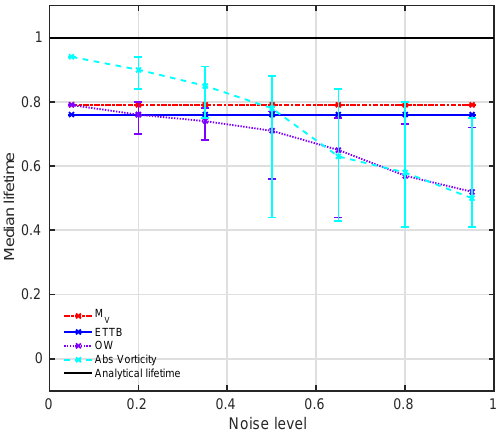
Figure 8. Measured median lifetime obtained by different methods (Okubo–Weiss (OW, violet), the modulus of vorticity (absVorticity, cyan), M V (red) and the eddy tracking tool box (ETTB, blue) by Nencioli et al. (2010)) depending on the noise level. The compu- tations have been performed in a velocity field mimicking a vortex street with type 2 noise (1000 noise realizations). The error bars in- dicate the whiskers of the distribution in the box plot (not shown here) corresponding to approximately ± 2.7 σ